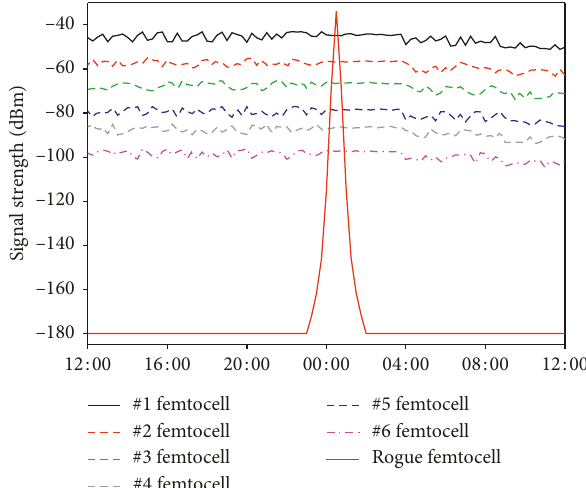
Figure 7: Signal strength profile of moving rogue and lawful